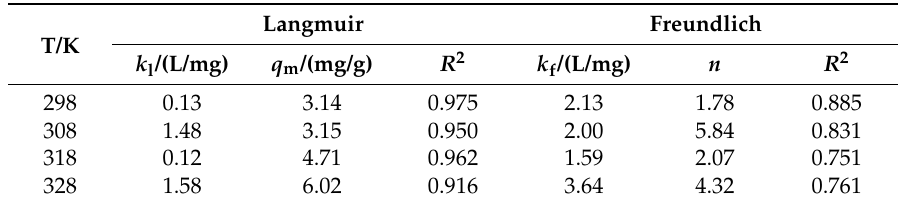
Table 4. Fitting results of isothermal adsorption of MG by M-PMs.